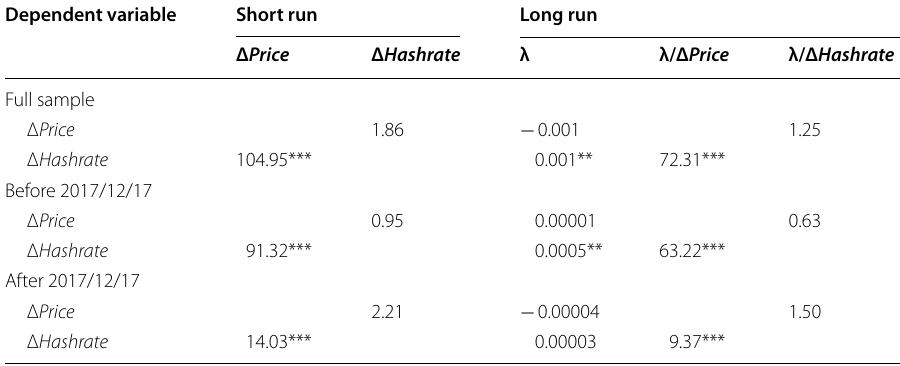
*, ** and *** show significance at the 10%, 5% and 1% levels,